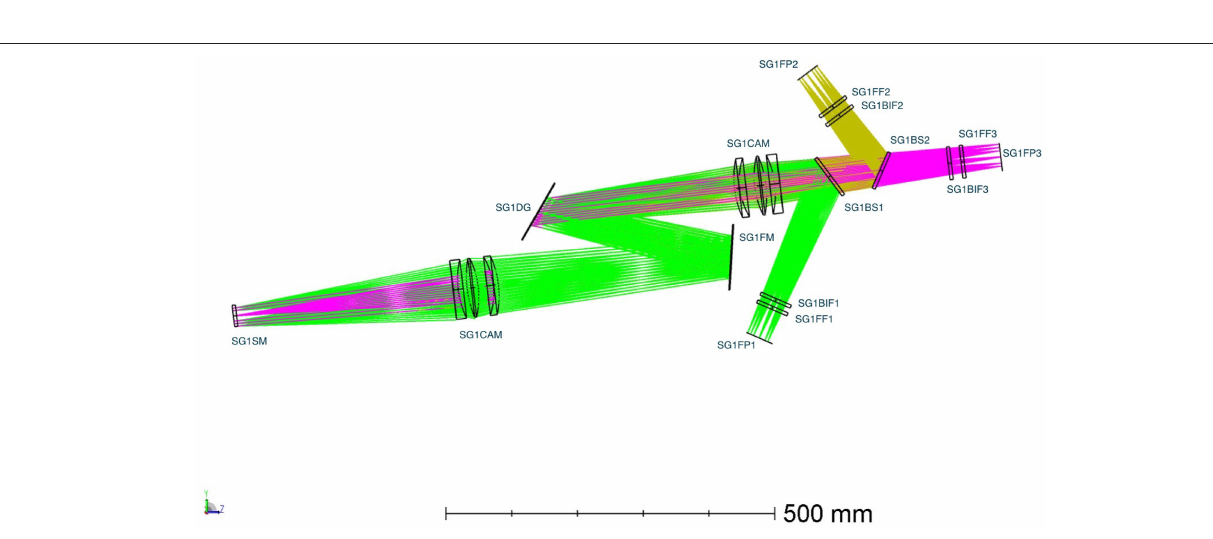
FIGURE 8 | The optical layout of mxCSM spectrograph.